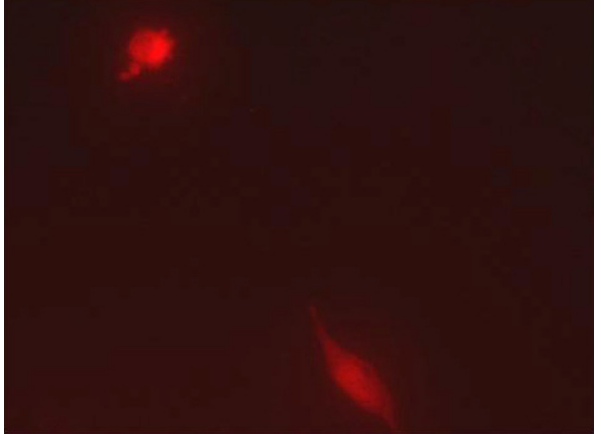
Figure 4. Transfection of RBE4 cells using pDNA-loaded lip-MNPs. The transfection efficiency of pDNA bound to MNPs is in the range of 20%–30% compared to that bound to Turbofect. The cells express the red fluorescent Hc-red protein in both the cell cytosol and